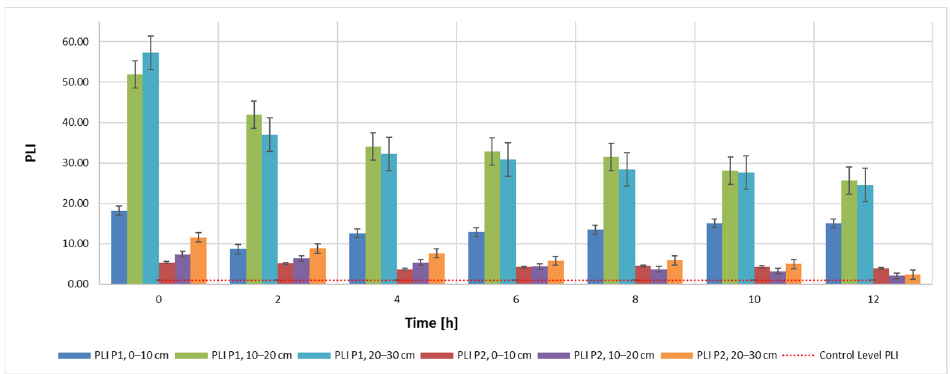
Figure 8. PLI—pollution load index during the extraction process according to admissibility limits and sampling depth using 40 mL 9K medium.